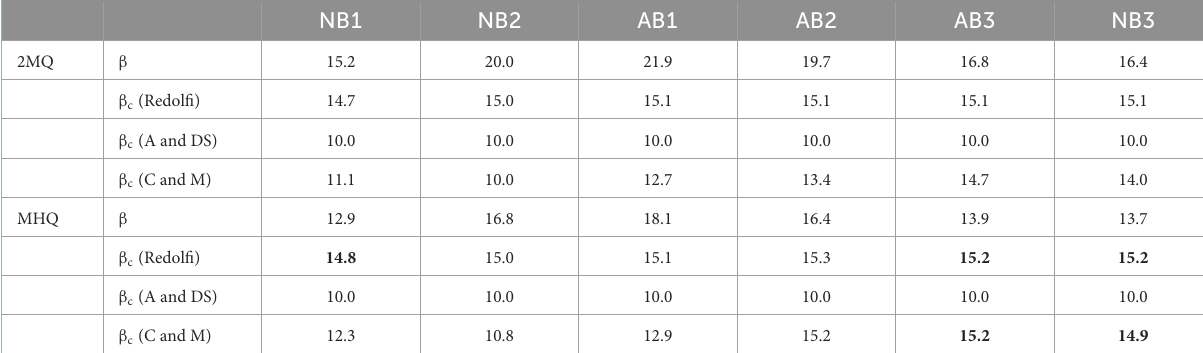
TABLE 2 Width to depth parameter β of the sections in comparison with β c calculated by the approaches of Redolfi (2021), Ahmari and Da Silva (2011) (A and DS) and Crosato and Mosselman (2009) (C and M) for the approximate bankfull discharges 2MQ and